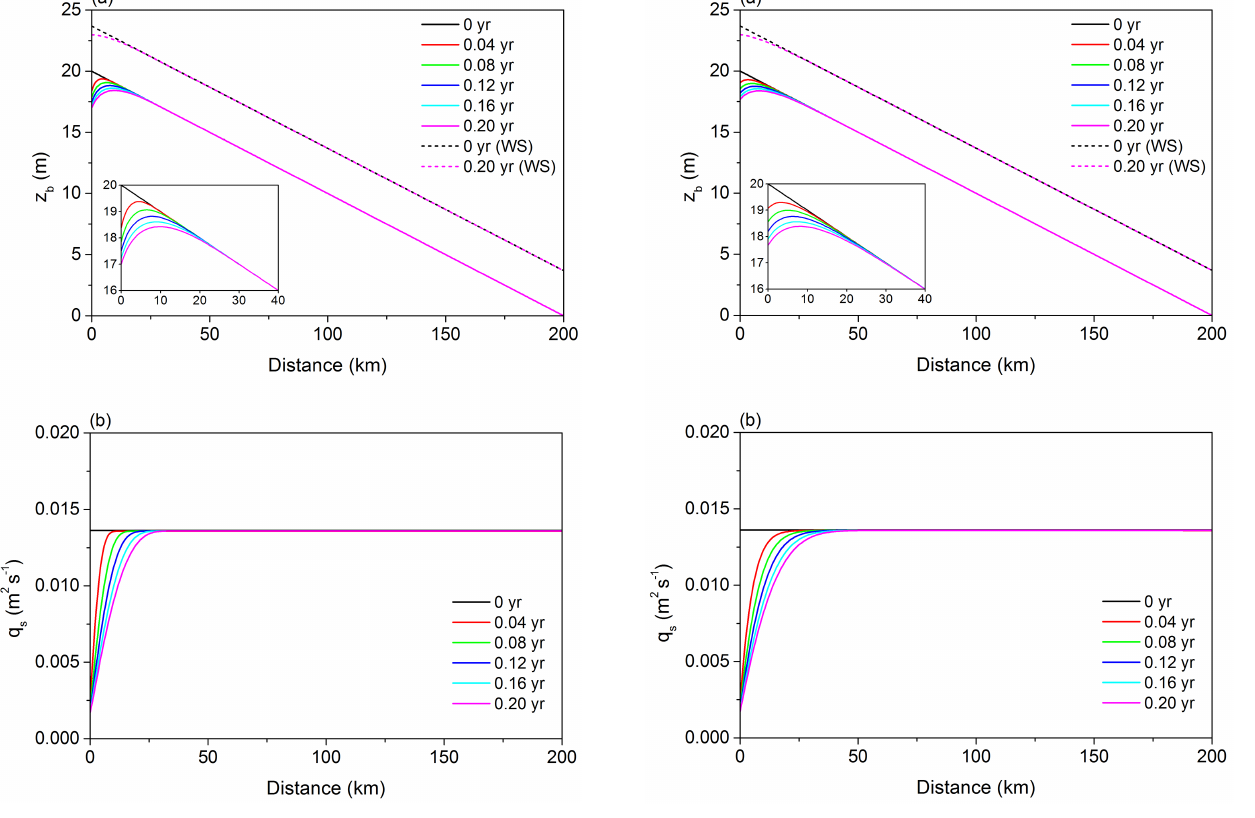
Figure 4. The 0.2-year results for the case of uniform sediment using the entrainment form of the Exner equation: time variation of (a) bed elevation z b and water surface (WS), (b) sediment load per unit width q s of the LYR in response to the cutoff of sediment supply. The inset shows detailed results near the upstream